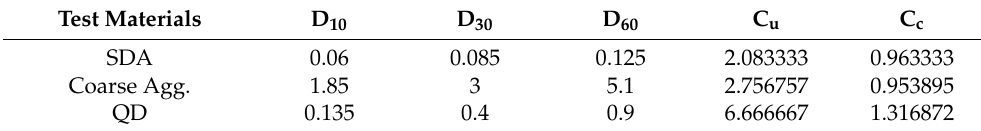
Figure 4. Particle Size Distribution Plot. Table 3. Gradation Coefficients.